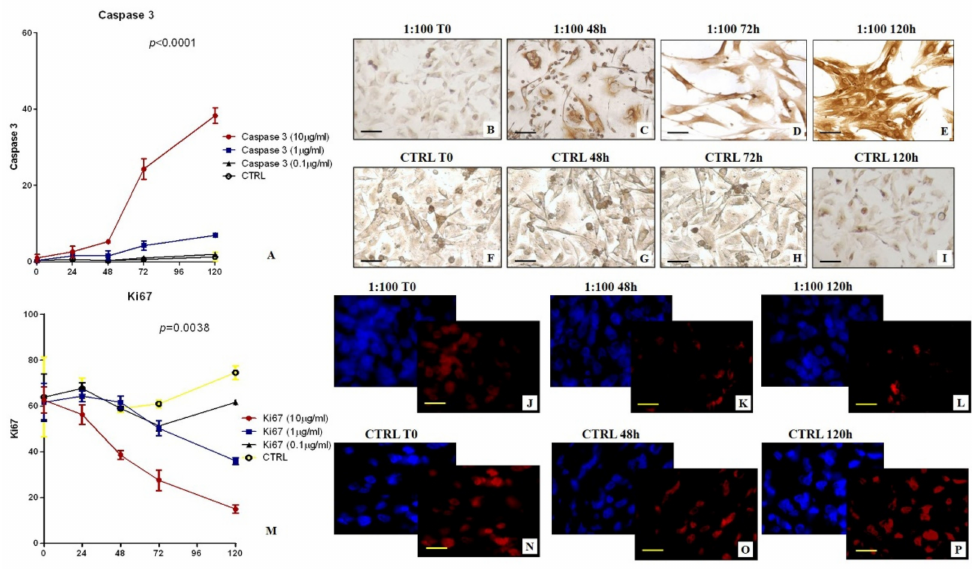
Figure 2. In vitro evaluation of the effect of [99mTc]Tc-Sestamibi on BT474 breast cancer cells. ( A ) The graph shows the number of caspase-3-positive BT474 breast cancer cells after sestamibi treatment. ( B ) No/rare caspase-3-positive cells at T0. ( C ) The image shows caspase-3-positive cells after 48 h of [99mTc]Tc-Sestamibi incubation (10 µ g/mL). ( D ) Numerous caspase-3-positive cells after 72 h of [99mTc]Tc-Sestamibi incubation (10 µ g/mL). ( E ) High number of caspase-3-positive cells